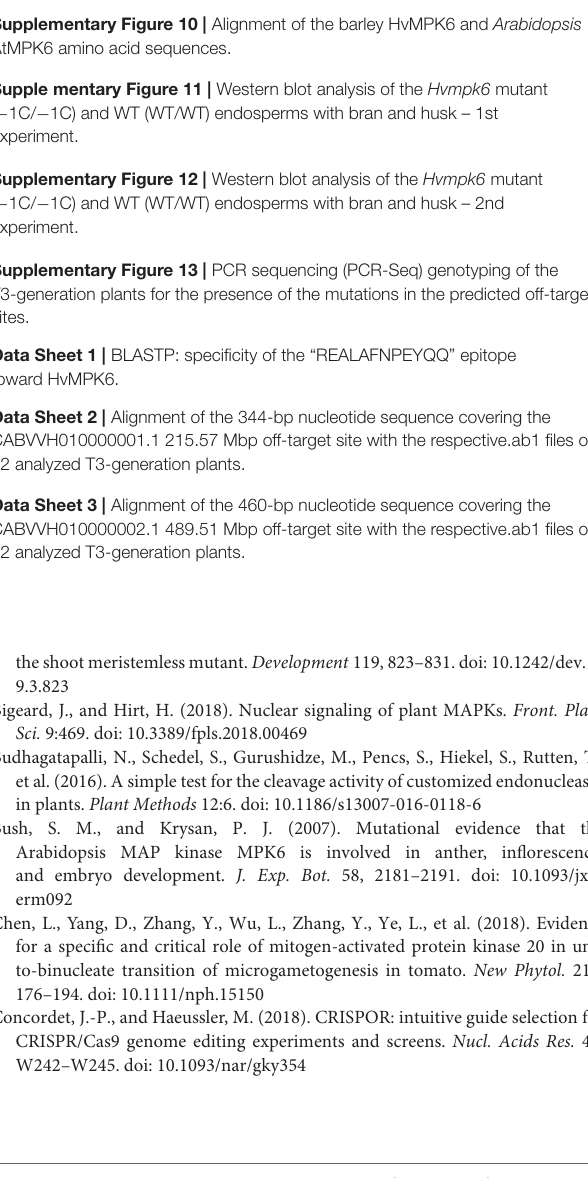
Supplementary Figure 2 | Comparison of the transcripts associated with the HvMPK6 gene. Supplementary Figure 3 | Superimposed sequencing chromatograms associated with plants chimeric in the induced mutations. Supplementary Figure 4 | Ploidy estimation of the transgenic line A. Supplementary Figure 5 | Alignment of the HvMPK6 amino acid sequence with the amino acid sequences of putative proteins resulting from CRISPR/Cas9-edited HvMPK6 . Supplementary Figure 6 | HvMPK6 alleles of the T2 progeny plants of a chimeric A4 plant. Supplementary Figure 7 | Phenotypic comparison of the abnormal transgenic WT and Hvmpk6 mutant ( − 1C/ − 1C) seedlings. Supplementary Figure 8 | A rare example of the abnormal seedling heterozygous in the HvMPK6 gene (WT/ − 1C), which, early after sowing, showed some signs of shoot emergence. Supplementary Figure 9 | Examples of the Hvmpk6 mutant ( − 1C/ − 1C) embryos with hints of the shoot part of the embryonic axis. Supplementary Figure 10 | Alignment of the barley HvMPK6 and Arabidopsis AtMPK6 amino acid sequences. Supple mentary Figure 11 | Western blot analysis of the Hvmpk6 mutant ( − 1C/ − 1C) and WT (WT/WT) endosperms with bran and husk – 1st experiment. Supplementary Figure 12 | Western blot analysis of the Hvmpk6 mutant ( − 1C/ − 1C) and WT (WT/WT) endosperms with bran and husk – 2nd experiment. Supplementary Figure 13 | PCR sequencing (PCR-Seq) genotyping of the T3-generation plants for the presence of the mutations in the predicted off-target